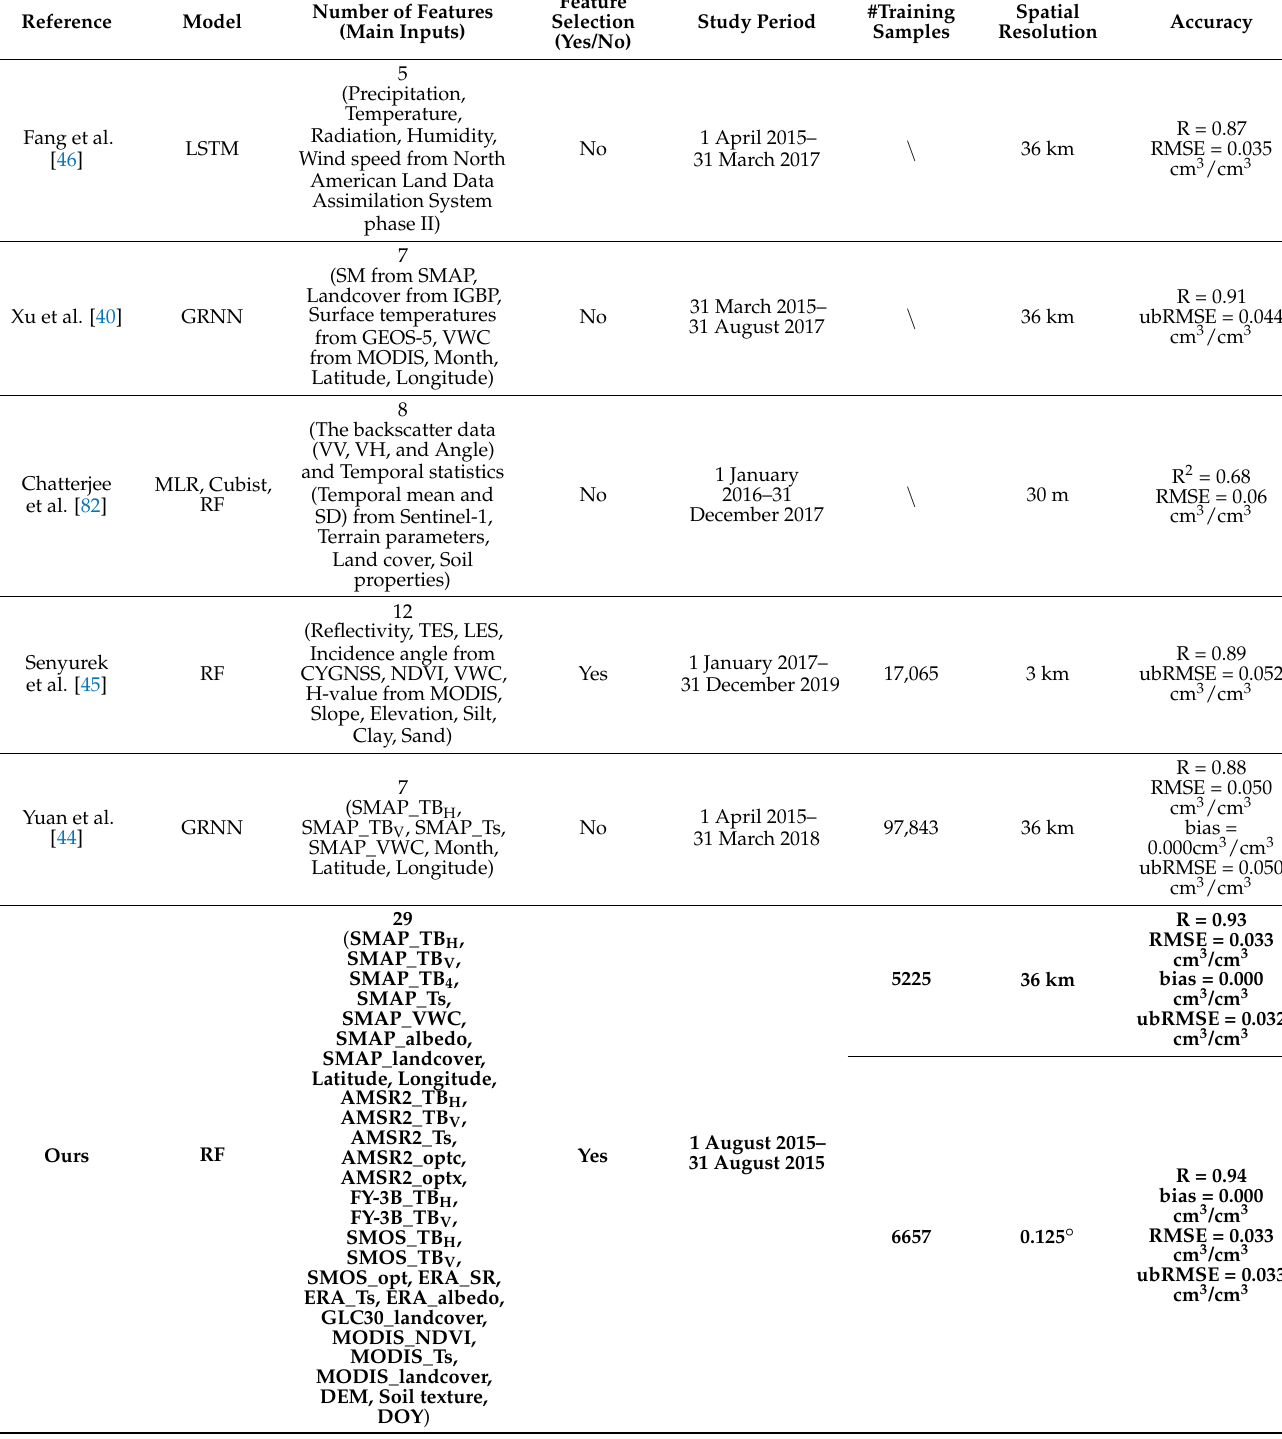
Table 8. Comparison of existing results obtained by related studies in the same study